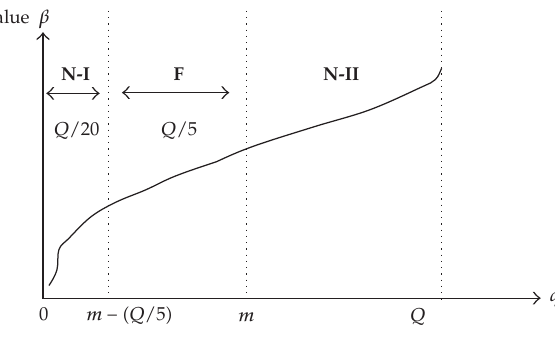
Figure 7: Decomposition of the